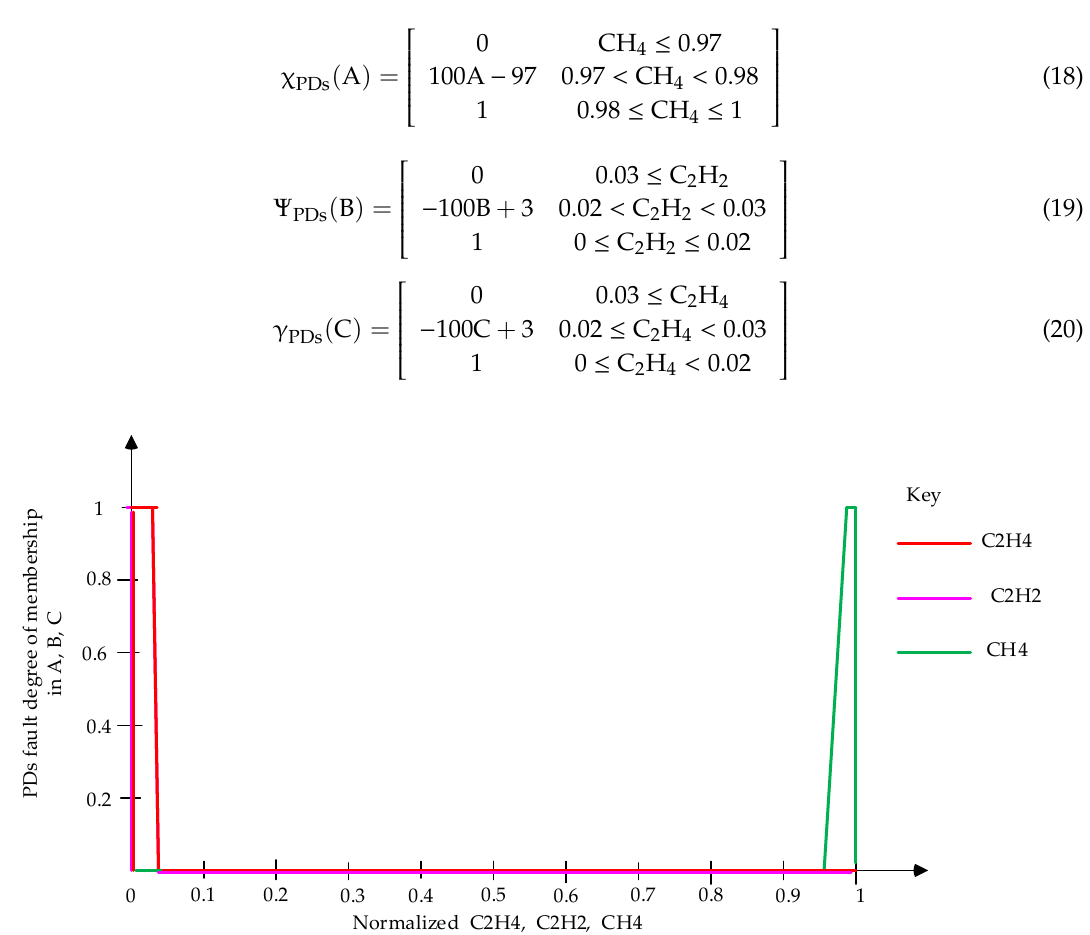
Figure 4. Fuzzy membership functions characterizing the presence of partial discharges (PDs).